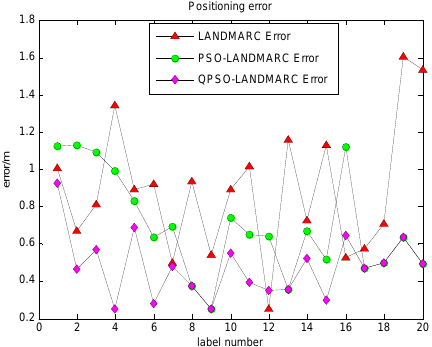
Figure 6. Localization error map.